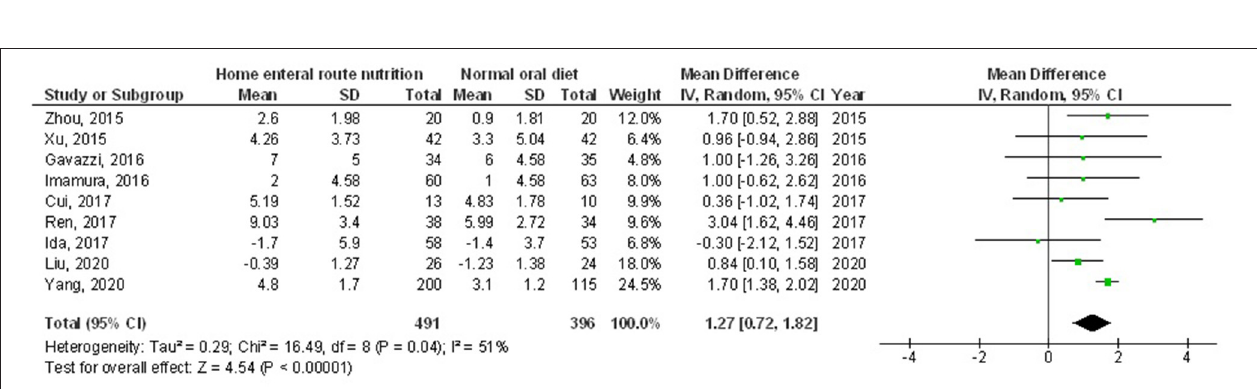
Frontiers in Surgery |